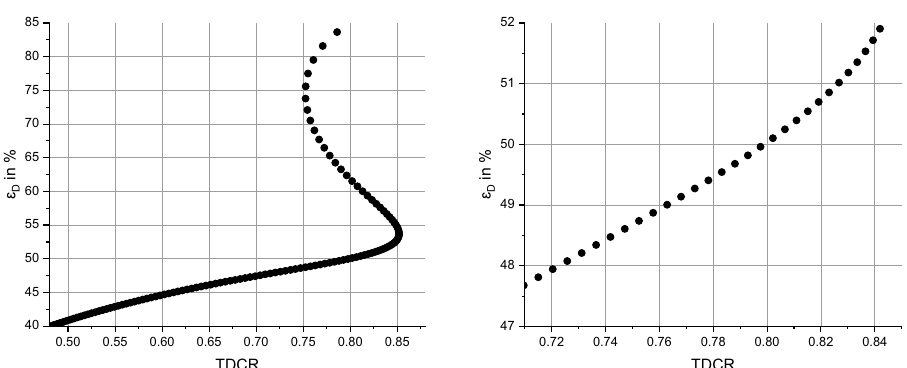
Figure 5. Computed double counting efficiency ε D as a function of the TDCR parameter. The ambiguity is a well-known effect which occurs for several radionuclides with complex decay schemes (see, e.g. 27 ). The right figure shows the same data in the ROI